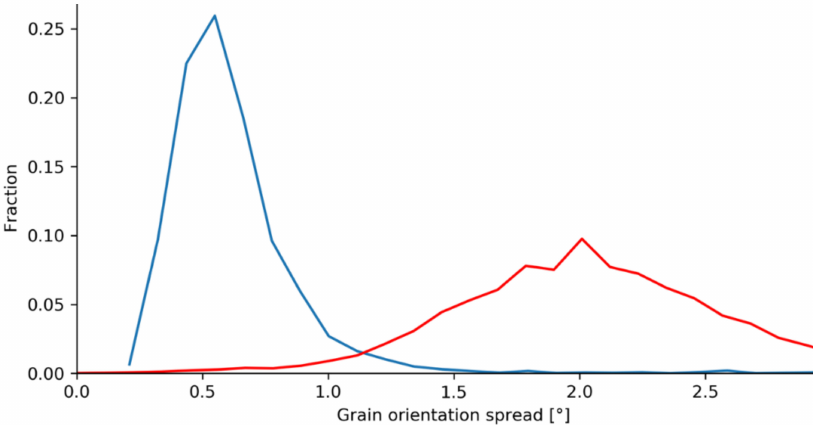
Figure 8. GOS chart-blue: recrystallized microstructure; red: not recrystallized microstructure.